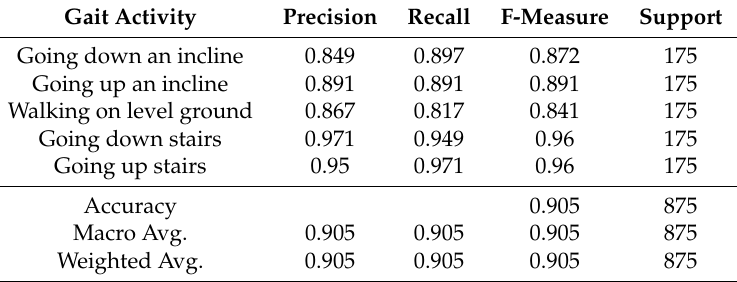
Figure 9. Loss behavior during training stage. To train the model the sampled dataset was used. Table 8. Classification report of the CNN model trained with the sampled